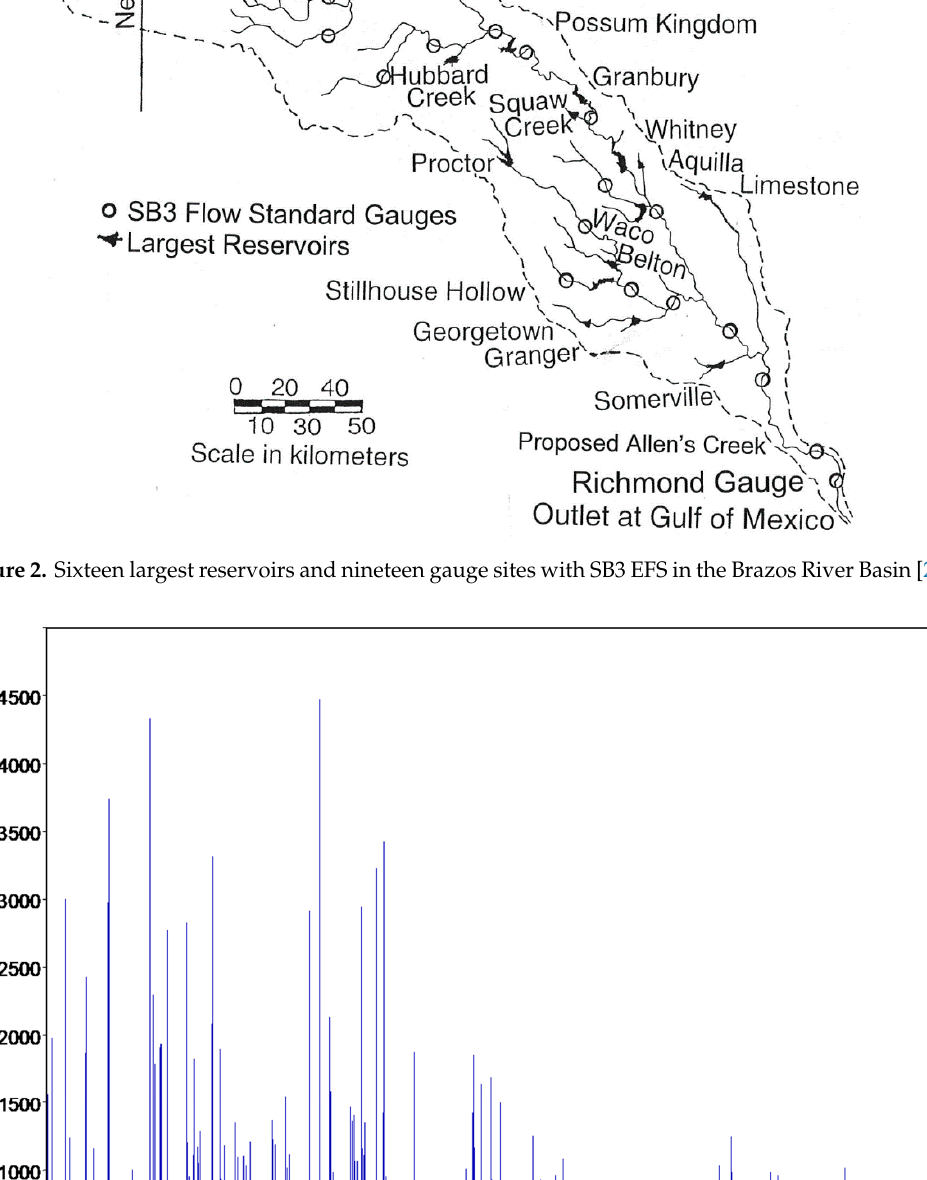
Figure 2. Sixteen largest reservoirs and nineteen gauge sites with SB3 EFS in the Brazos River Basin [27].